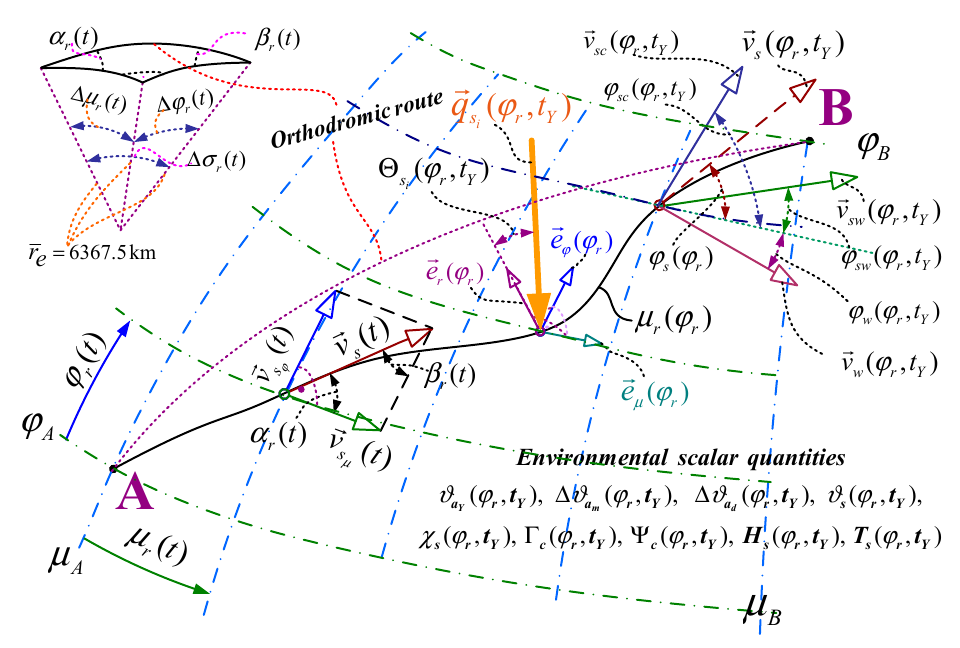
Figure 2. The navigation route through realistic surroundings.